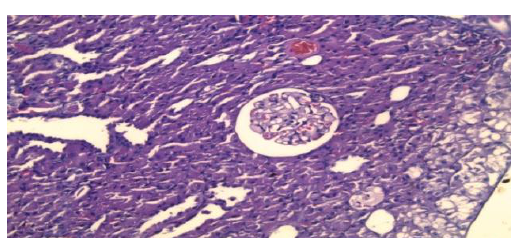
Figure (2): Saline kidney. Day 3 Rat n: 6(no changes)